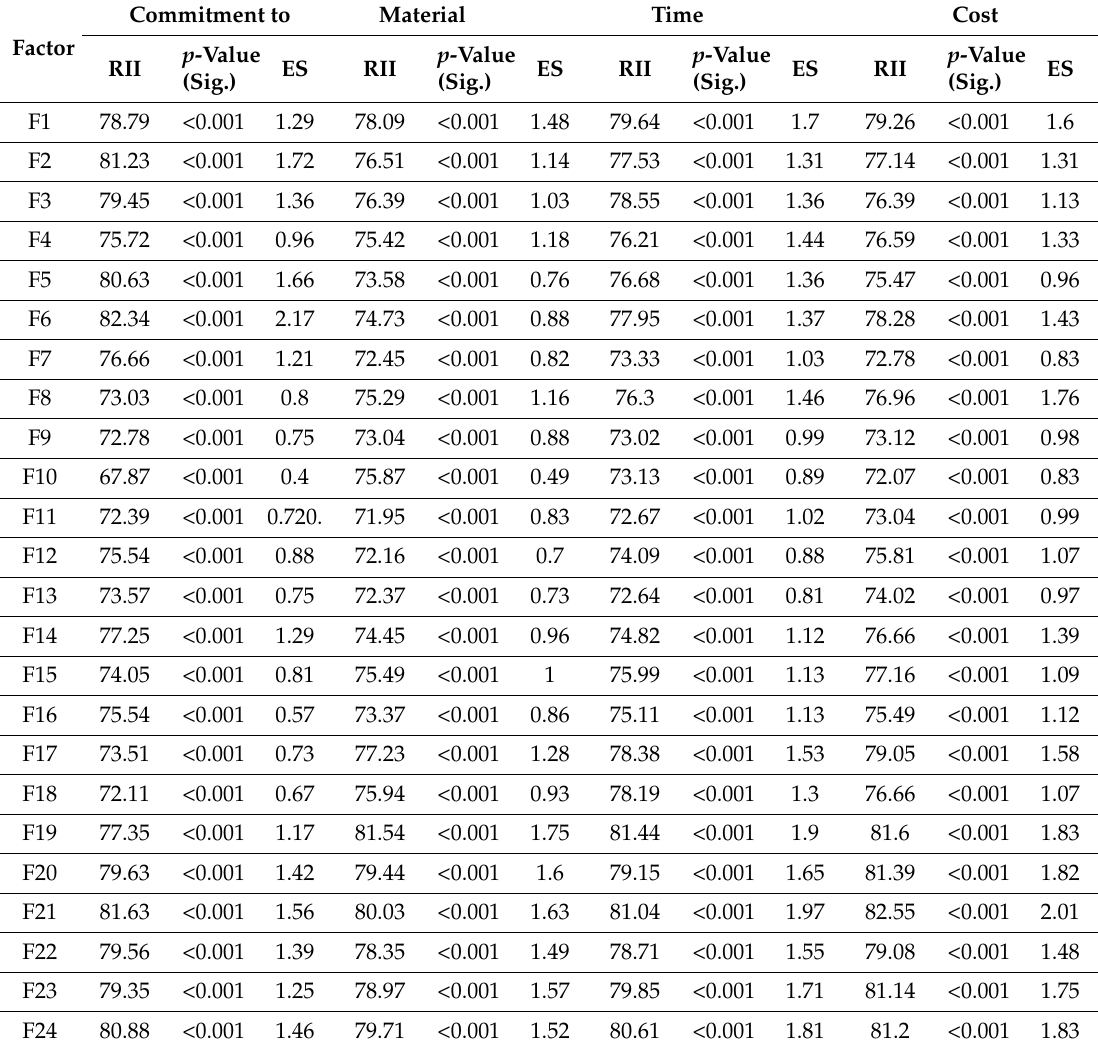
Table 6. RII and rank of the safety factors during